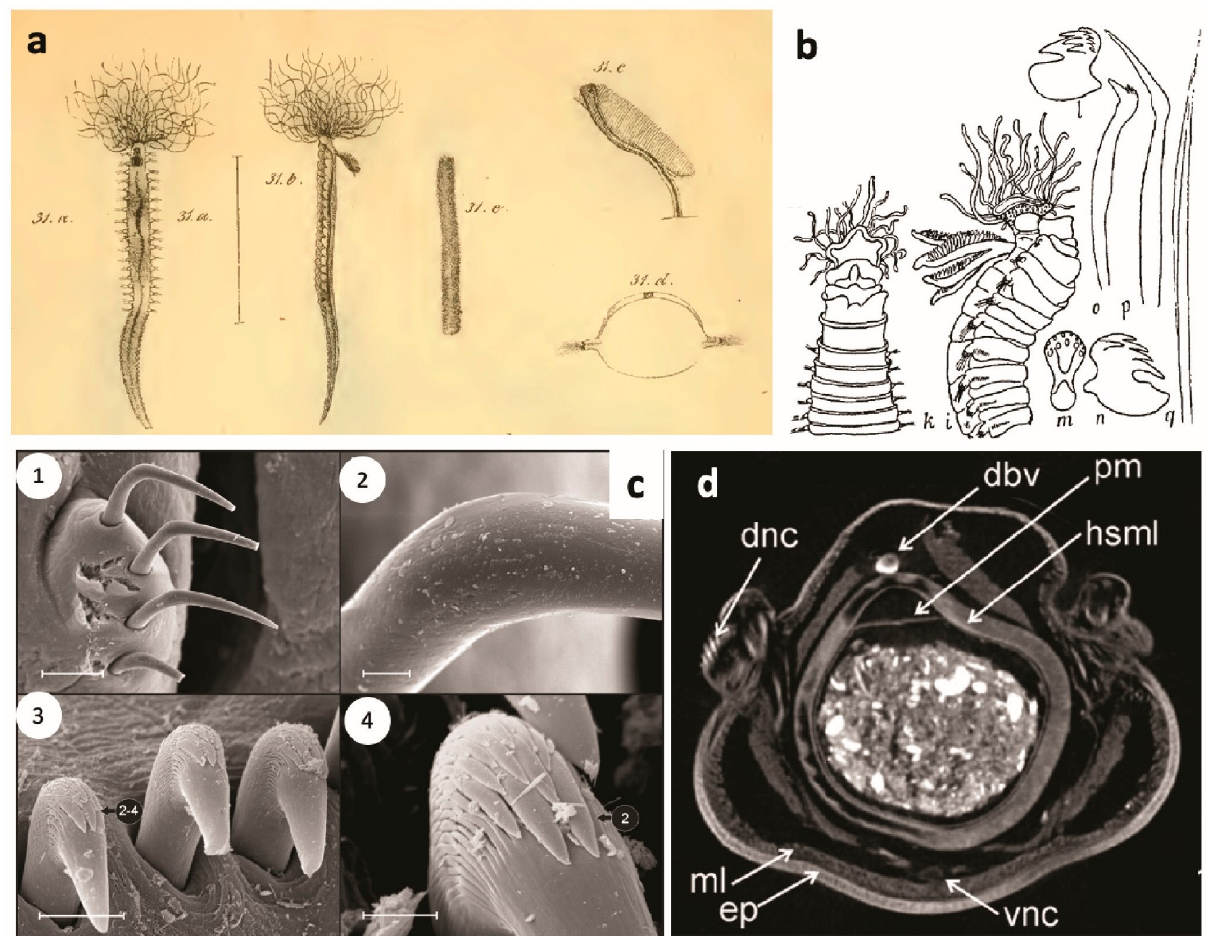
Figure 9. Evolution of appreciation of morphological traits important in taxonomy and techniques used, with Terebellides stroemii as an example. ( a ) Illustrations of the original description by Sars [108] (part of plate 13). ( b ) Later observations focused on optical microscopy of the chaetae (setae), here summarized by Fauvel [86]. Key: i side view of anterior part; k ventral view; l–n, uncini front and side view; o, thoracic ventral hook; p, geniculate chaeta; q, dorsal chaeta. ( c ) Scanning Electron Microscopy of geniculate chaetae (1) and detail of the bend (2), thoracic uncini (3) and detail of the teeth (4) (Parapar et al. [109]). ( d ) Micro-computed tomography ( µ CT) allows cross sections to look at the anatomical level. Here, section at the level of thoracic chaetiger 9. dnc, dorsal notochaetae; dbv, dorsal blood vessel; hsml, hind stomach muscle layer; ep, epidermis; ml, muscle layer; pm, peritrophic membrane; vnc, ventral nerve chord. (Modified after Parapar and Hutchings [110]). Scale bars a 50 µm, b 5 µm, c 10 µm, and d 3 µm.